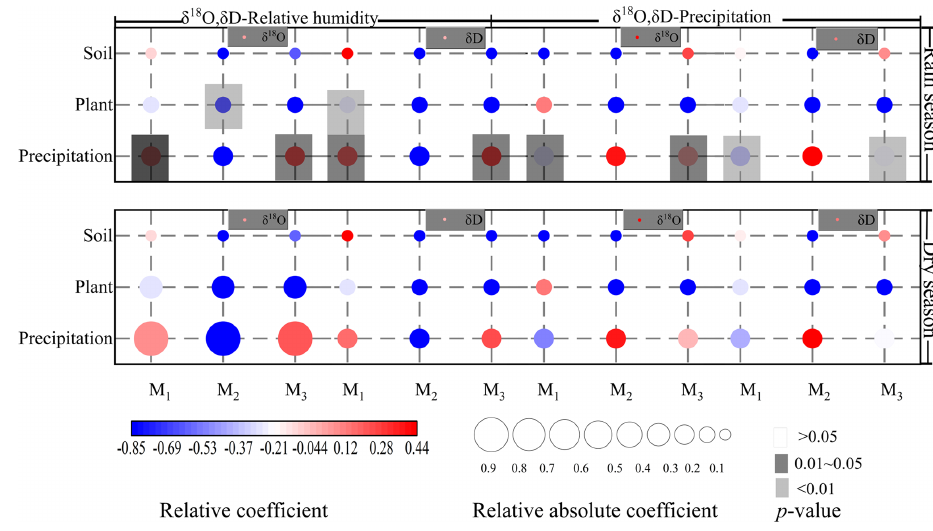
Figure 8. Relationship between different isotopes and relative humidity and precipitation; M 1 stands for alpine meadows; M 2 stands for forests; and M 3 stands for arid foothills. Table 4. Correlation between different isotopes’ δ 18 O and relative humidity and precipitation in different vegetation zones. Meteorological Isotope types Rainy season Dry season parameters Alpine meadow Forest Arid foothills Alpine meadow Forest Arid foothills Relative